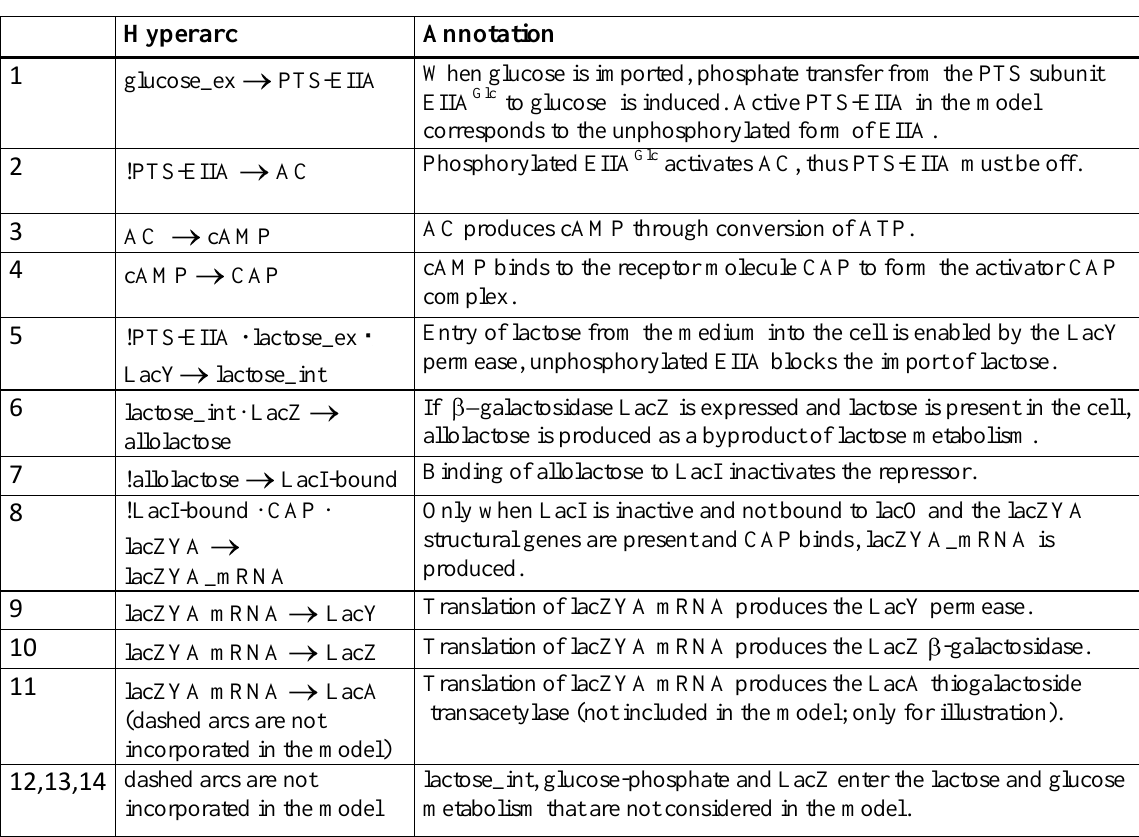
Table 2: Hyperarcs of the Boolean lac operon model. Exclamation mark within the equations denote a logical NOT, dots indicate AND